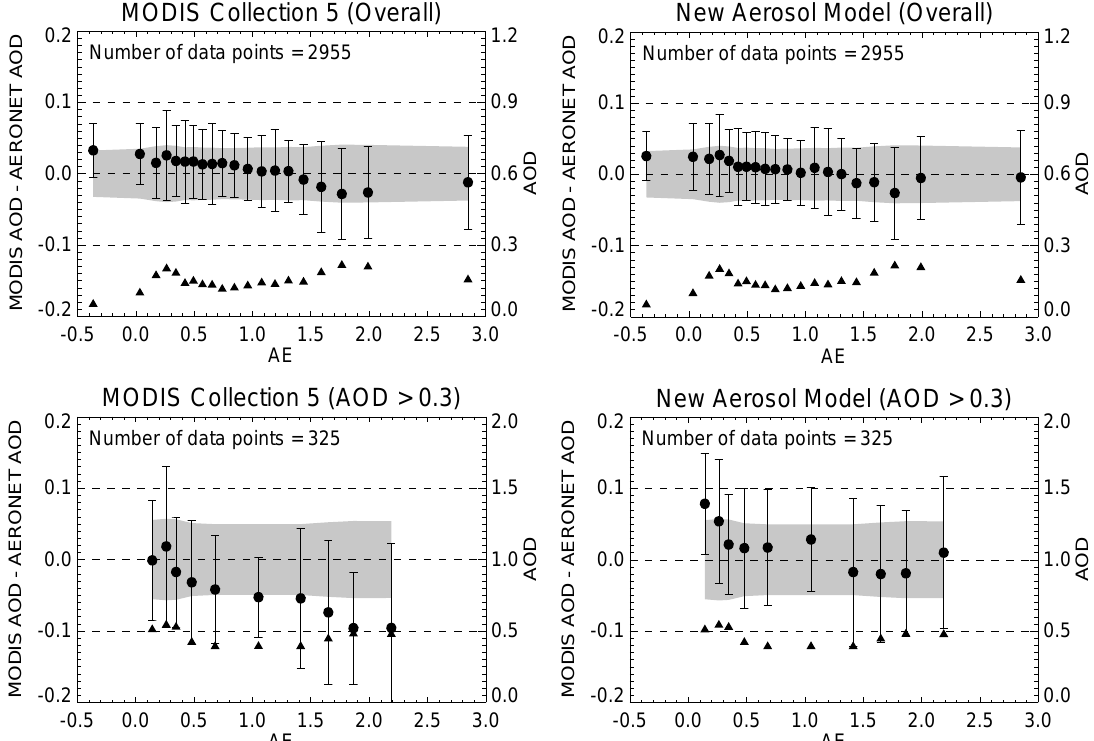
Fig. 7. AE dependence of retrieval errors for the C005 algorithm (left) and the test algorithm (right) for overall data (upper) and data for AOD > 0.3 (lower). The data are sorted in 20 and 10 equal-number-of-data bins for the overall case and high AOD case, respectively. The dots and bars represent mean and one-standard deviation intervals of the retrieval errors, respectively, while the triangles represent the mean AOD from AERONET in each